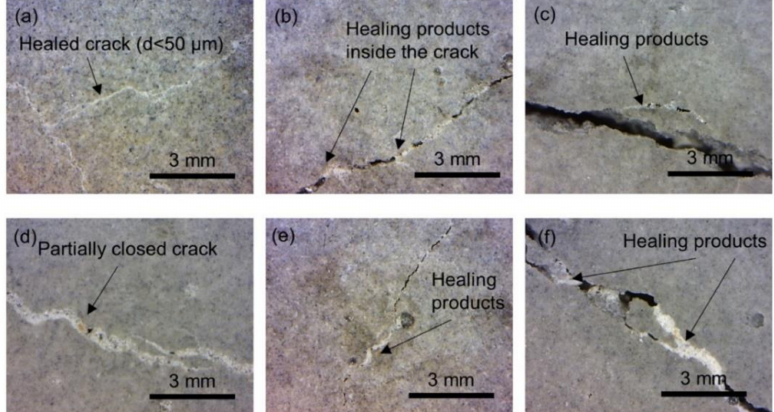
Figure 18. The images of surface cracks on UHPC layer filled with self-healing products ( a ) fully healed crack; ( b – f ) partial healed